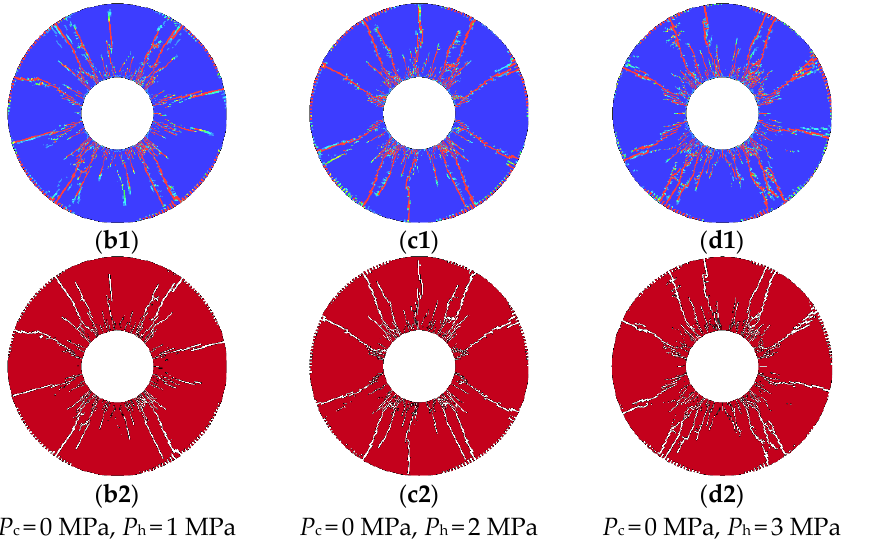
Figure 12. Case 1: ( a1 , b1 , c1 , d1 ) damage distribution in rock; ( a2 , b2 , c2 , d2 ) crack pattern.